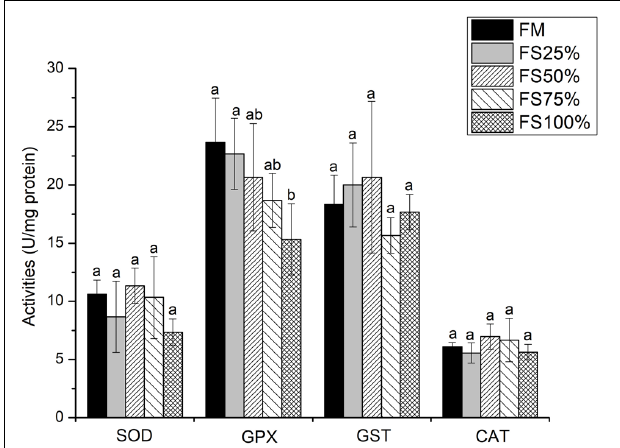
FIGURE 2 | Specific activities of hepatopancreas antioxidant enzymes of shrimp fed with five different diets. Results are shown as the mean ± SD, and different letters above a bar represent a significant difference ( P < 0.05). SOD, superoxide dismutase; GST, glutathione S-transferase; GPX, glutathione peroxidase; CAT,